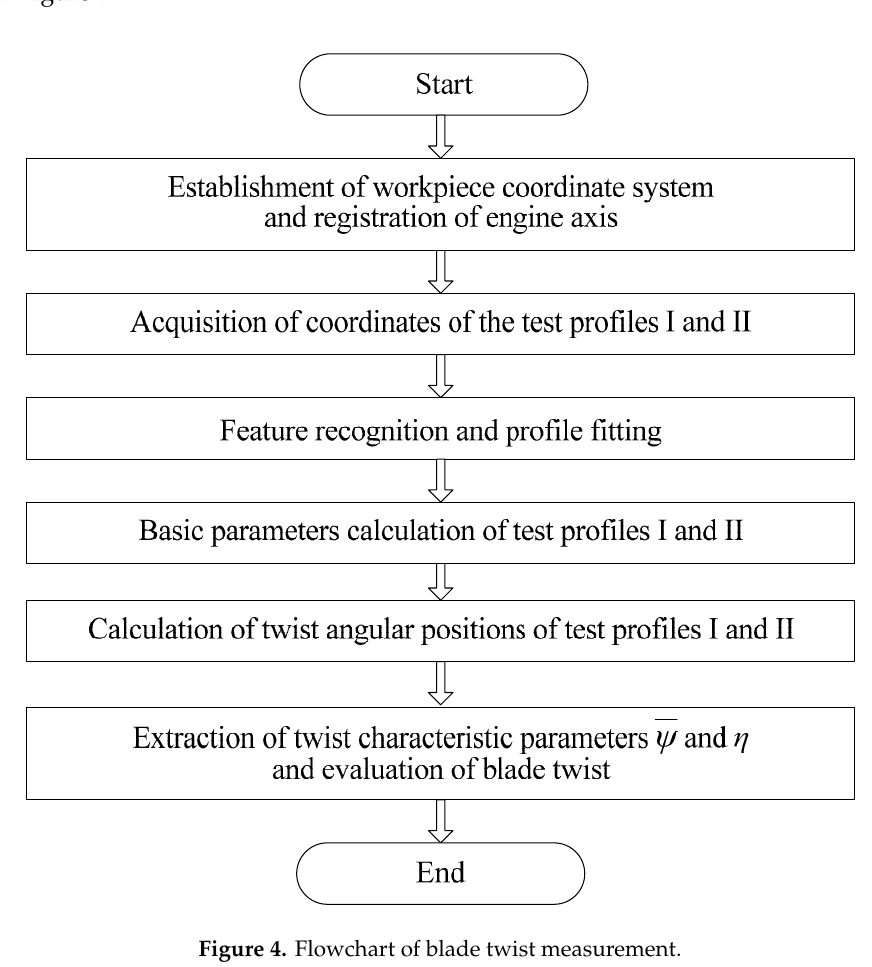
Figure 4. Flowchart of blade twist measurement.